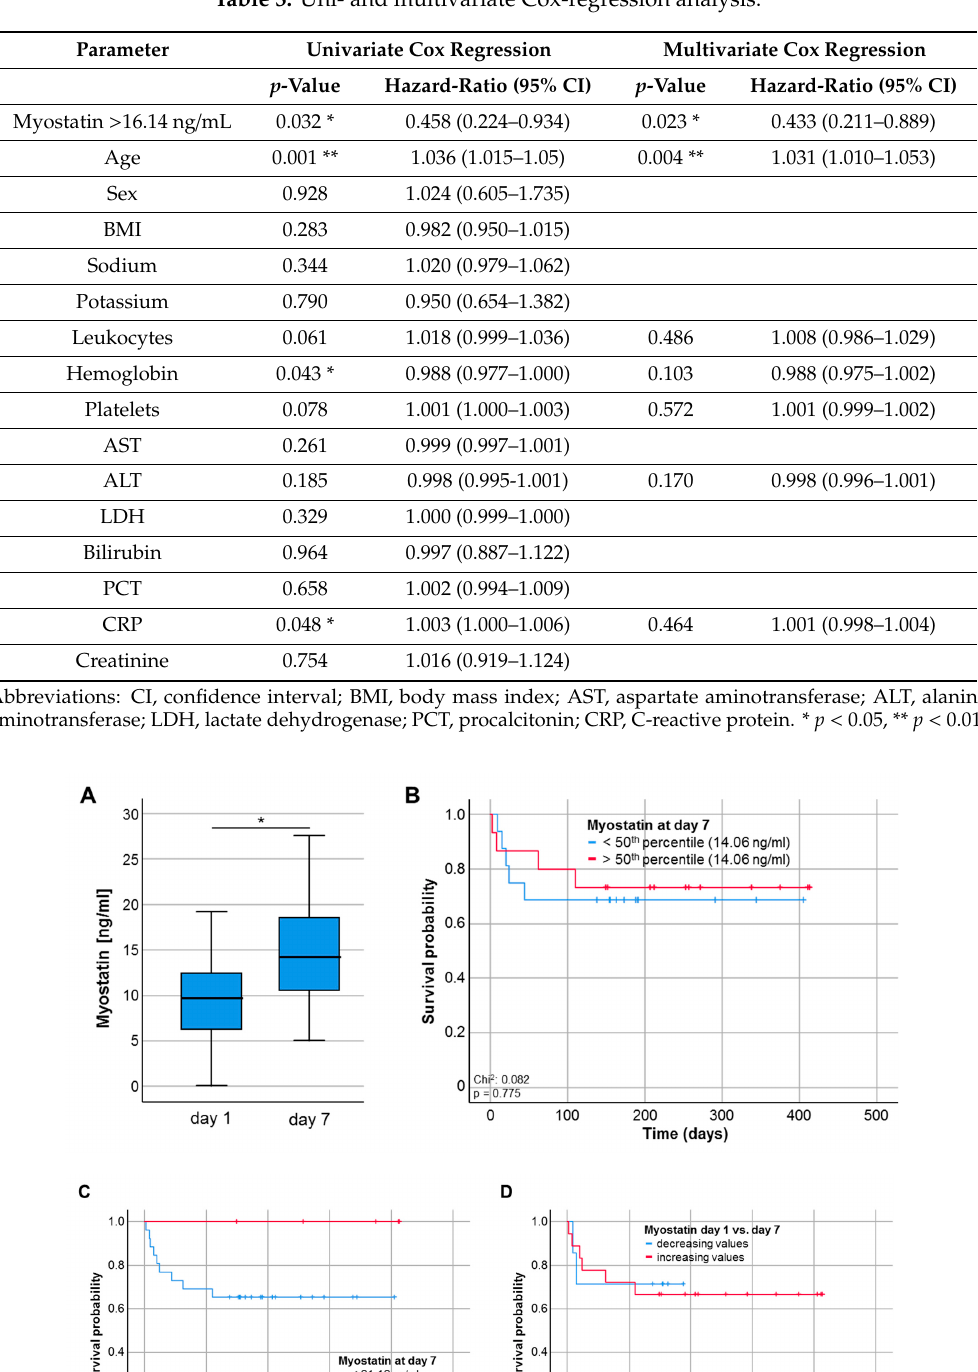
Table 3. Uni- and multivariate Cox-regression analysis.